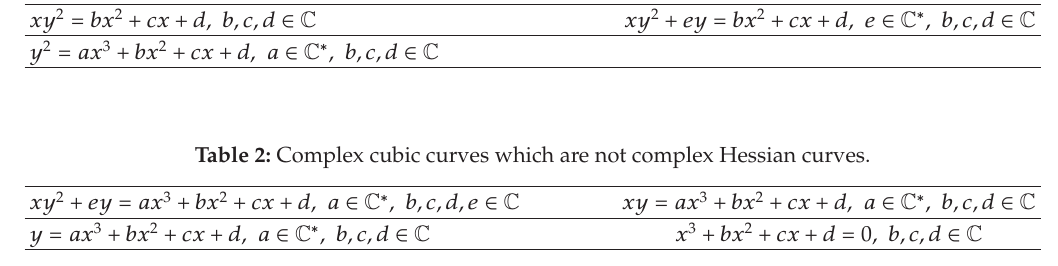
Table 1: Complex Hessian cubic curves.